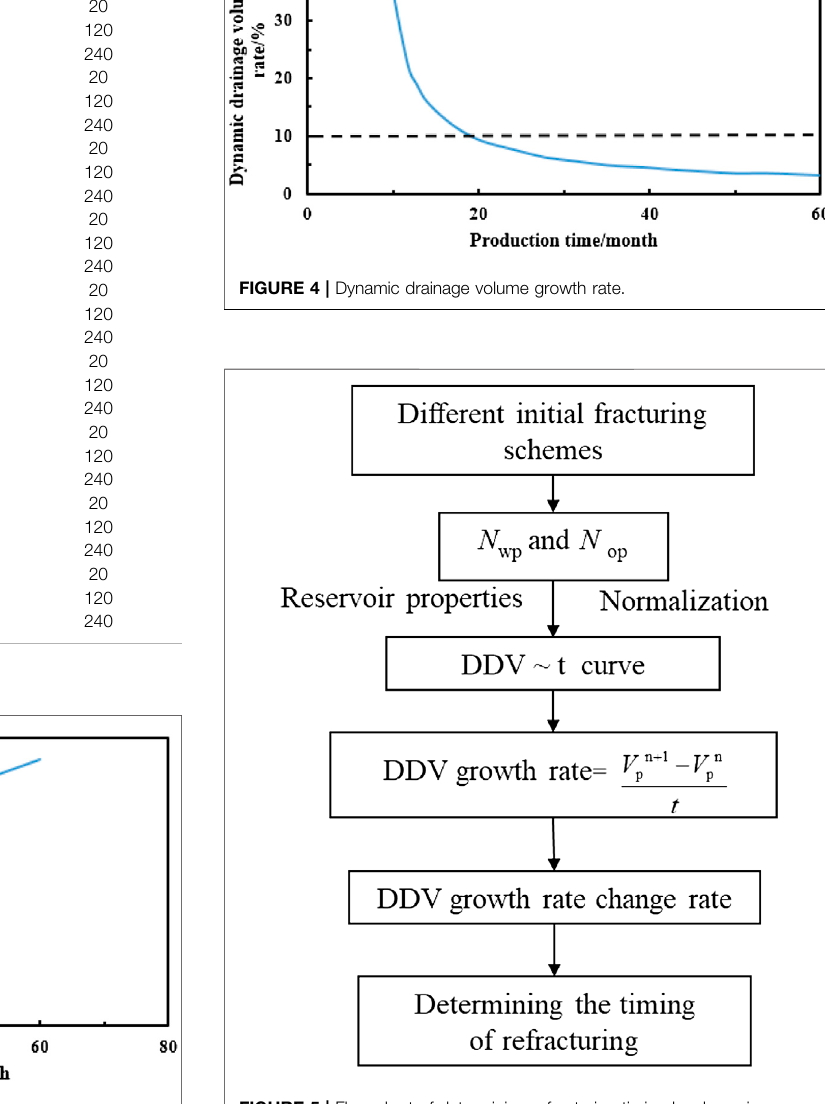
FIGURE 3 | Dynamic drainage volume variation over time.